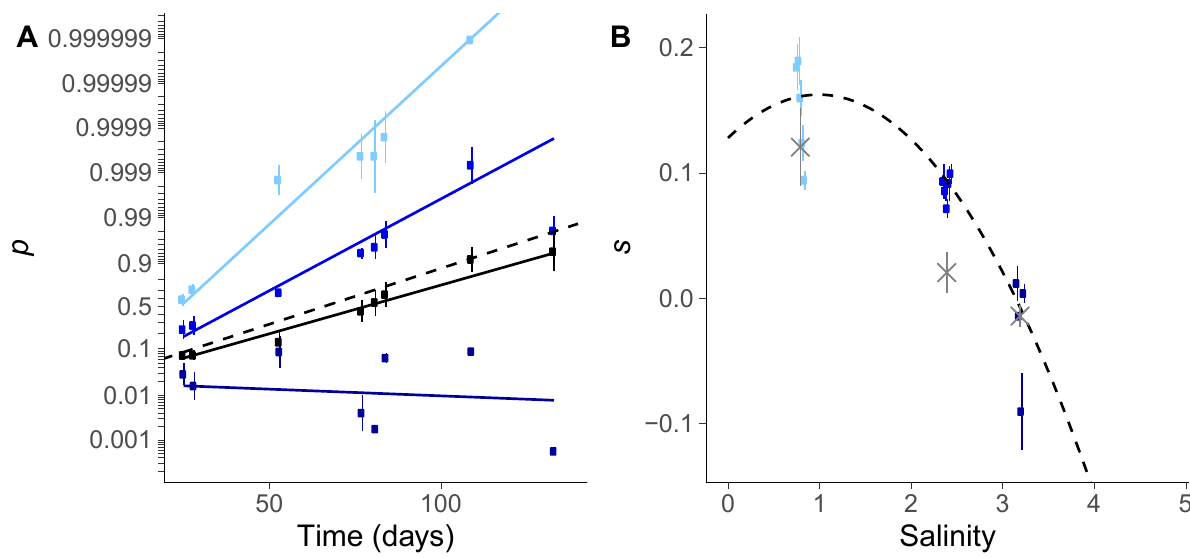
Fig 3. Mean selection in fluctuating versus constant environment. (A) Mean trajectories of logit allelic frequency over time. Solid lines represent logistic regression fits (Eqs (1) and (2)), while dots and error bars are time-specific estimates and bootstrapped standard deviations of logit frequencies, based on random factors in the state-space model. Black: fluctuating salinity (all autocorrelations treatments were pooled). Blue: constant salinities, from lighter to darker: 0.8M, 2.4M and 3.2M. The dashed line is the mean logit frequency dynamics as predicted from the selection reaction norm in panel b. (B) Selection reaction norm in constant environment. The selection coefficient for strain C is shown as dots and error bars for the logistic regression fit independently in each independent AC populations (colors match those in panel a). The dashed line represents the model that includes the influence of salinity on selection (selection reaction norm), and the gray crosses are the prediction from the difference in growth rates between strains A and C in monoculture (with error bars corresponding to the standard